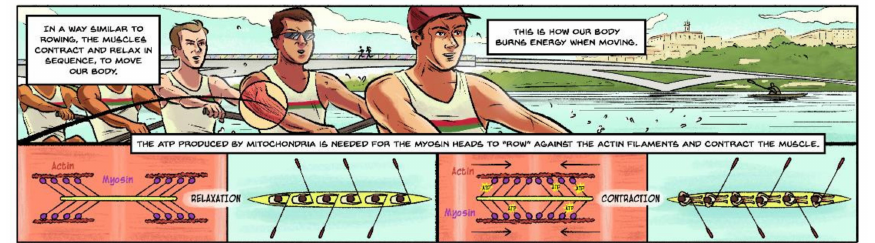
Figure 2. The introduction of a common activity (rowing) to stress the movements of myosin and actin filaments relevant in muscular